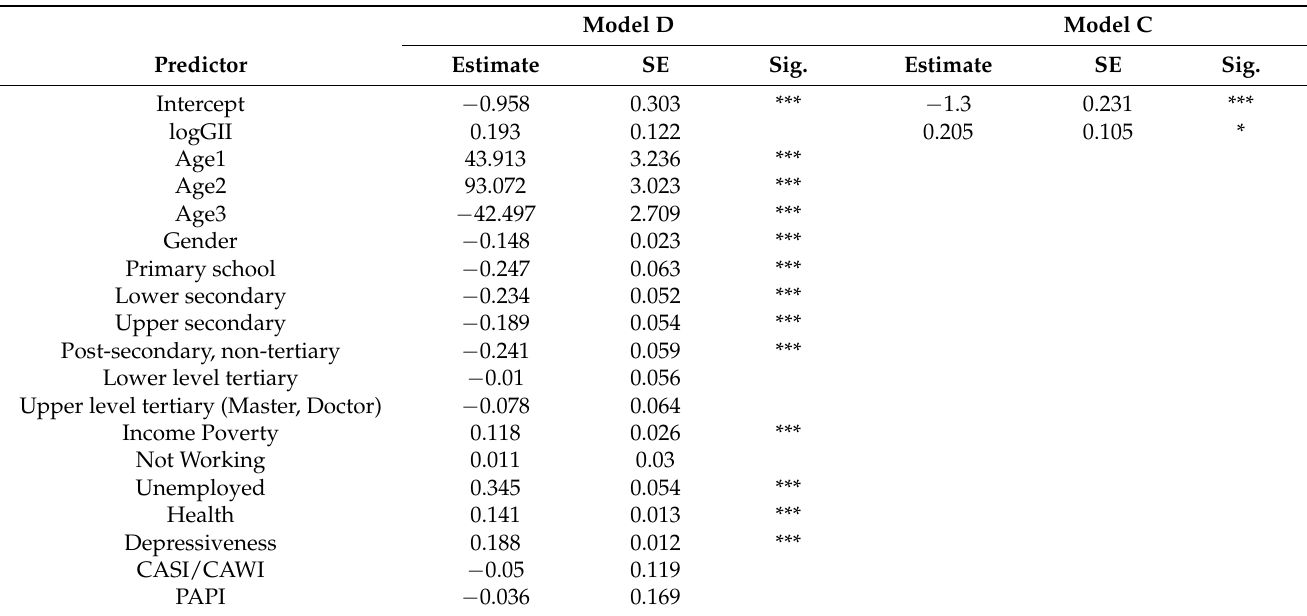
Table A5. Multilevel logistic models of effect of GII on the probability of emotional isolation (SNI emo < 3) (Full Table